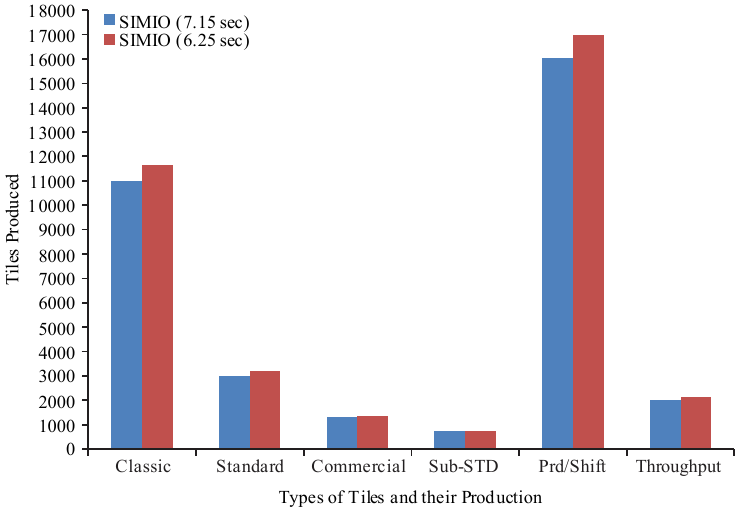
FIG. 10. RESULTS OF COMPARISON OF NUMBER OF TILES PRODUCED FOR INTER ARRIVAL TIME OF 7.15 AND 6.25